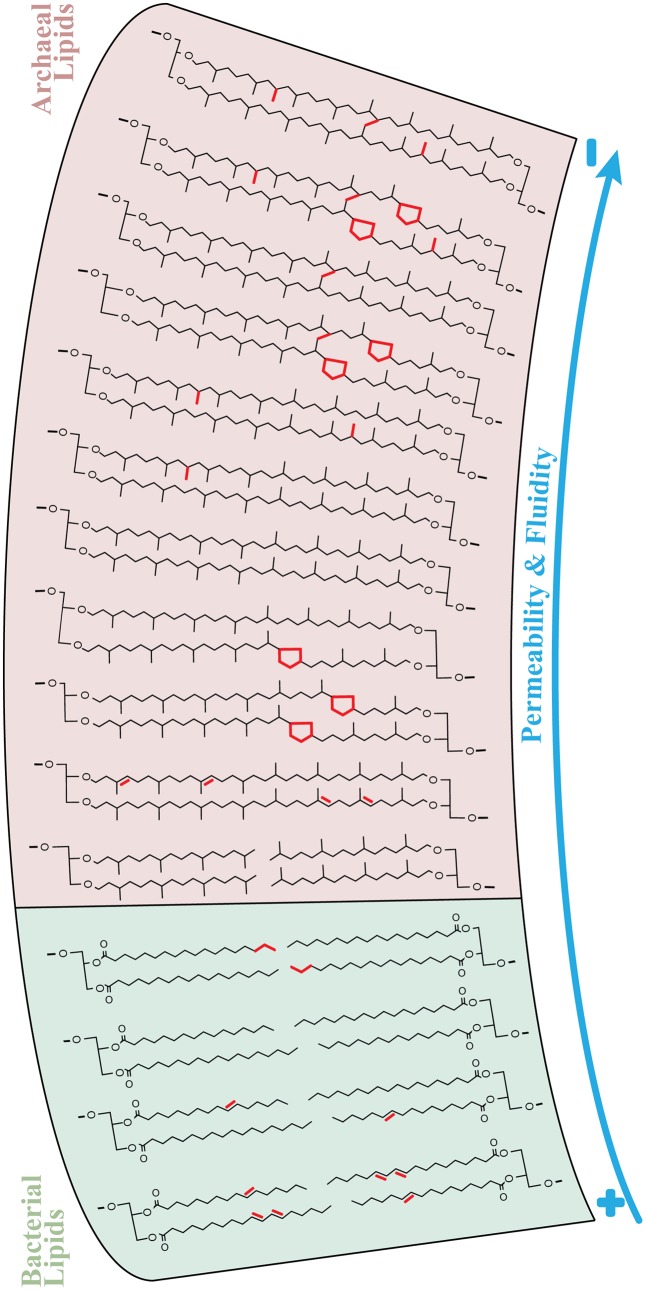
Lipid chemical structures determining ion permeability (e.g., proton and sodium) and fluidity of archaeal and bacterial membranes in sediments of Milos. The arrows indicate a continuum trend from high (+) to low (–) membrane permeability and fluidity. The essential structural distinction between archaeal and bacterial lipid membranes are the ether-linked isoprenoids in the former and typical ester-linked fatty acids in the latter. The permeability and fluidity properties of bacterial membranes were mainly regulated by the degree of unsaturation (i.e., number of double bonds) and chain length of fatty acids (highlighted in red), as shown in Figure 5. Apart from the transition diether to tetraether, i.e., bilayer to monolayer membranes, archaea featured several modifications in tetraethers that are suggested to influence the permeability and fluidity properties of their membranes (Figure 5). These features (in red) include unsaturation, cyclization and methylation of biphytane(s) and covalent bonds between isoprenoidal chains (H-shaped).